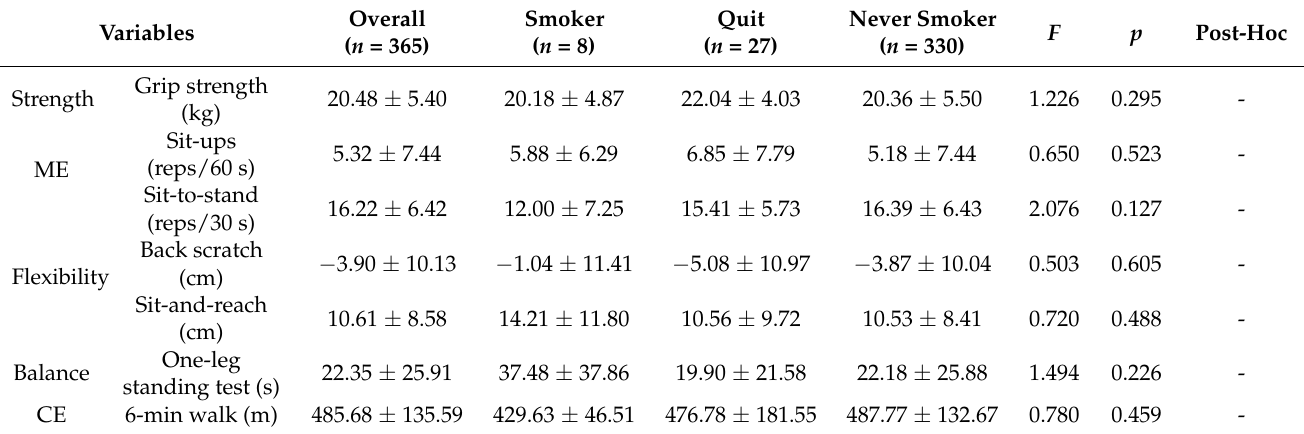
Table 5. Differences in physical fitness variables based on smoking in elderly